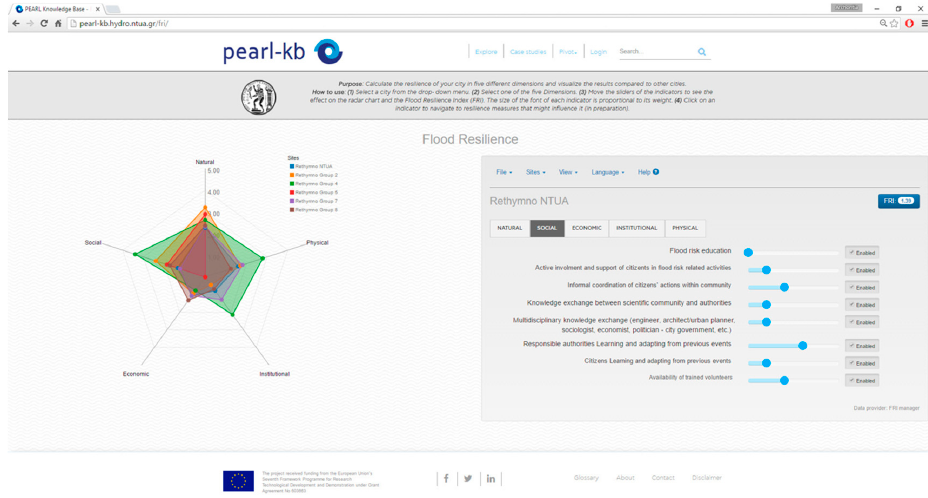
Figure 12. Main web page of the PEARL FRI Tool.